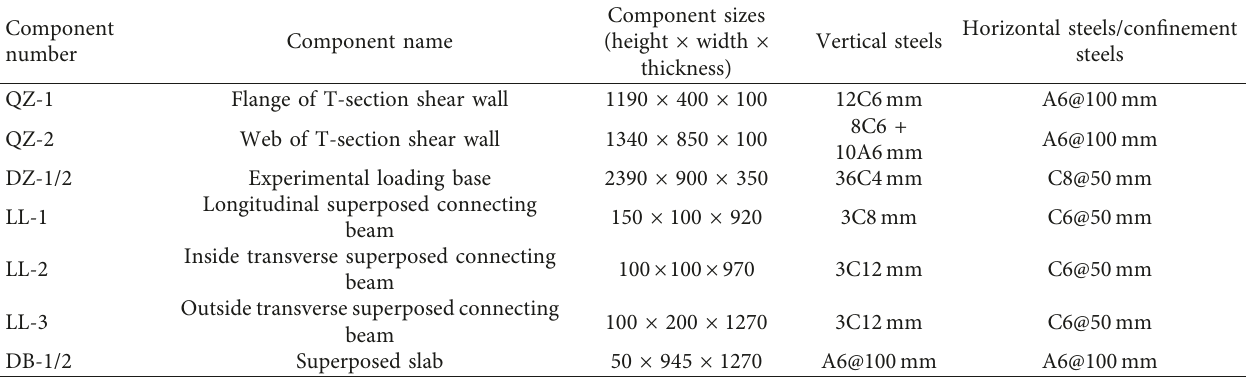
Table 1: Sizes and reinforcements in NPGCS spatial model components